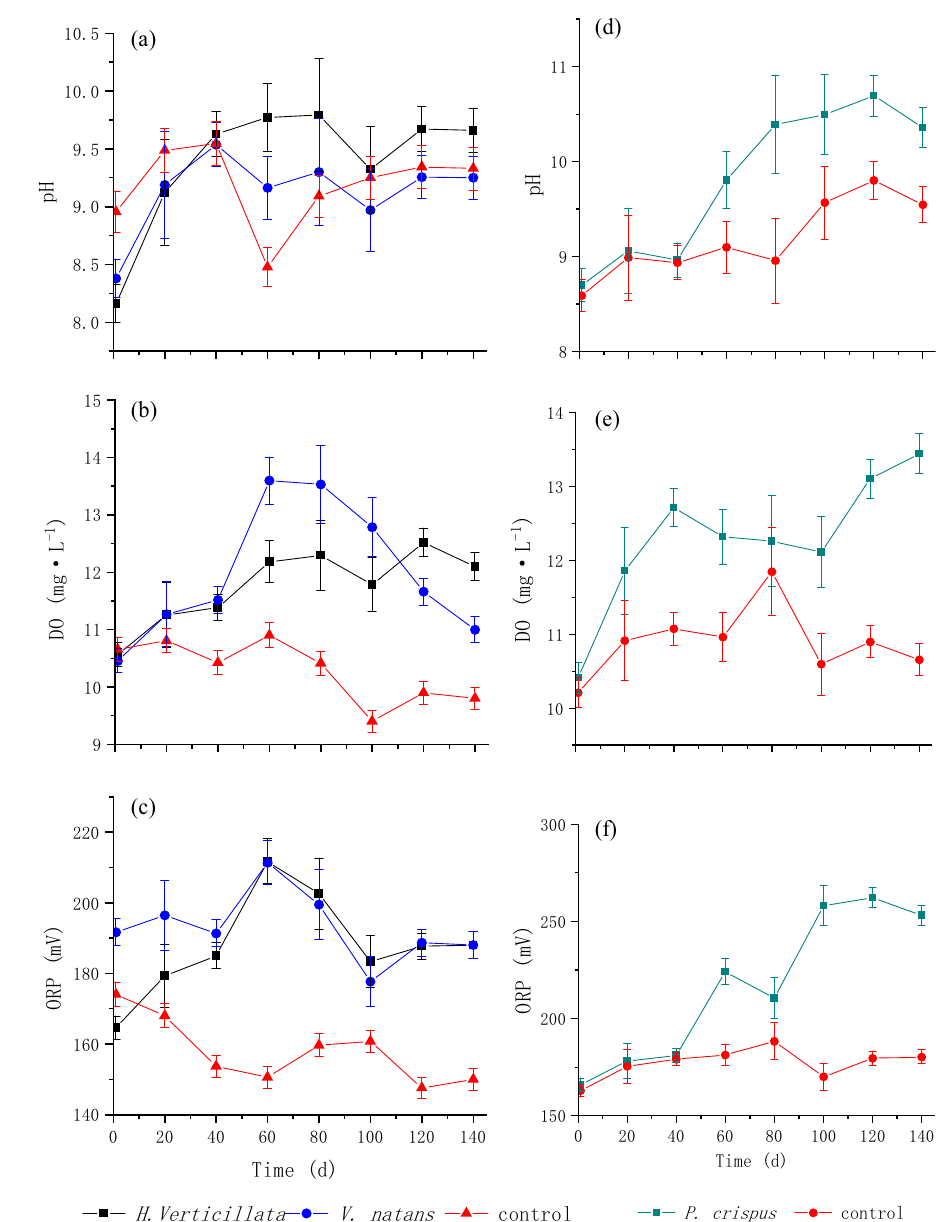
Fig. 5 Changes in environmen- tal factors of water during the study period. The results are the mean ± standard